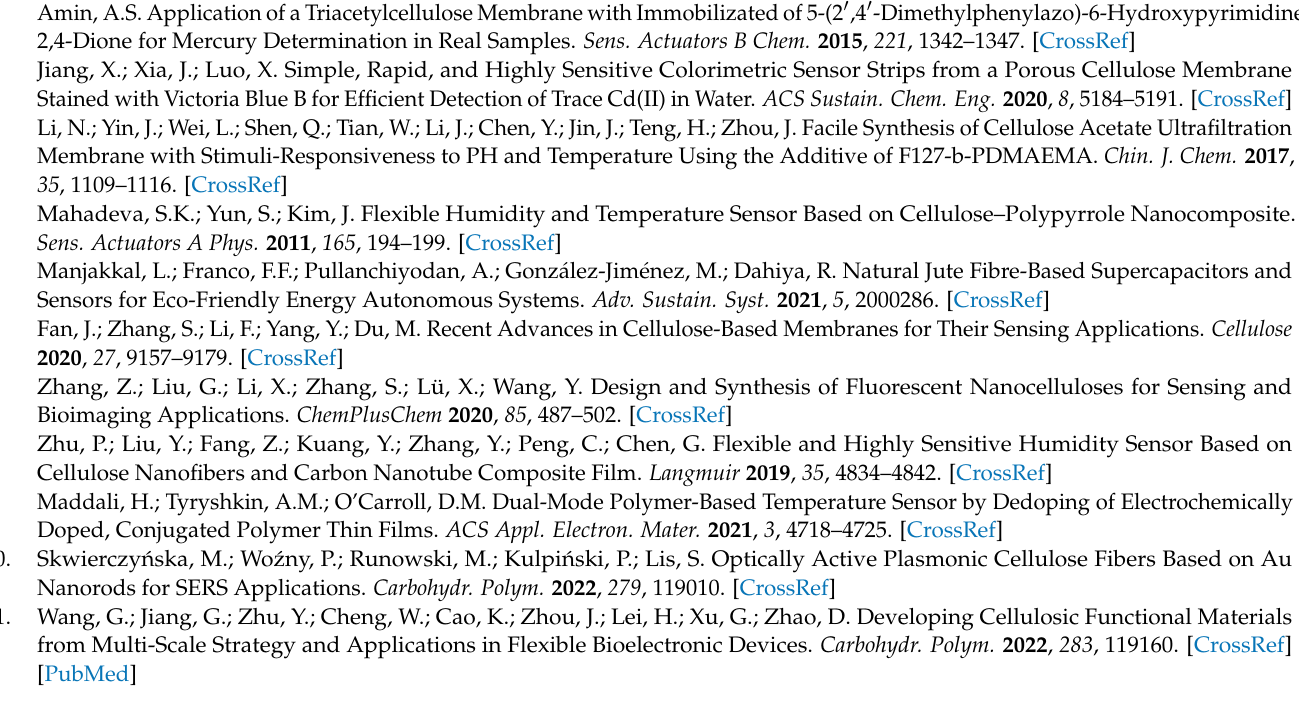
Figure S2: DLS analysis of YF 3 : 20% Yb 3+ , 2% Er 3+ NPs; Figure S3: EDX spectra of YF 3 -modified cellulose fibers; Table S1: Basic structural and physical parameters of a knitted fabric made of YF 3 - modified cellulose fibers; Figure S4: Thermal cycling of YF 3 -modified fibers between 298 K and 362